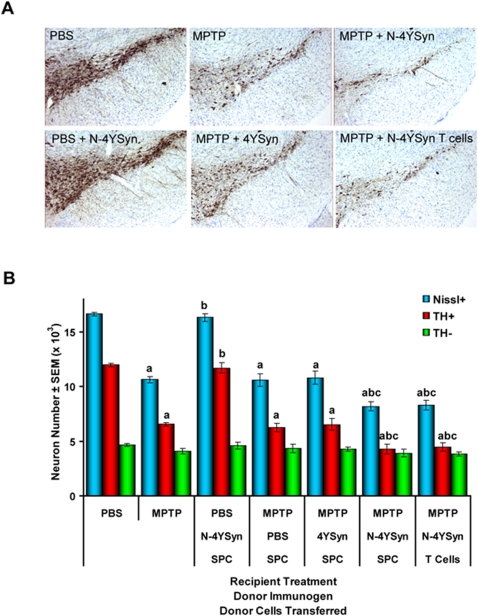
N-4YSyn immunization with adjuvant exacerbates dopaminergic neuronal cell loss in B10.BR mice.(A) All panels show TH-positive neurons in the SN from mice treated with: [top row, L to R] PBS or MPTP alone, MPTP and SPC from N-4YSyn immunized donors (MPTP+N-4YSyn), [bottom row, L to R] PBS and SPC from N-4YSyn immunized donors (PBS+N-4YSyn), MPTP and SPC from 4YSyn immunized donors (MPTP+4YSyn), and MPTP and T cells from N-4YSyn immunized donors (MPTP+N-4YSyn T Cells). Tissues collected 28 days post-MPTP treatment (B) Counts of nigral Nissl+ (blue bars), TH+ (red bars), and TH- (green bars) neurons on day 28 after MPTP treatment as determined by stereological analysis. Control groups included mice treated with PBS alone (n = 4), MPTP alone (n = 8), and PBS animals that received immune effector SPC from N-4YSyn immunized donor mice PBS/N-4YSyn/SPC (n = 6). Experimental groups included MPTP/PBS/SPC (n = 6), MPTP/4YSyn/SPC (n = 8), MPTP/N-4YSyn/SPC (n = 9), and MPTP mice which received purified T cells from N-4YSyn vaccinated donors. Values are means ± SEM. p<0.01 compared to the following treatment groups: aPBS, bMPTP, cMPTP/4YSyn/SPC.